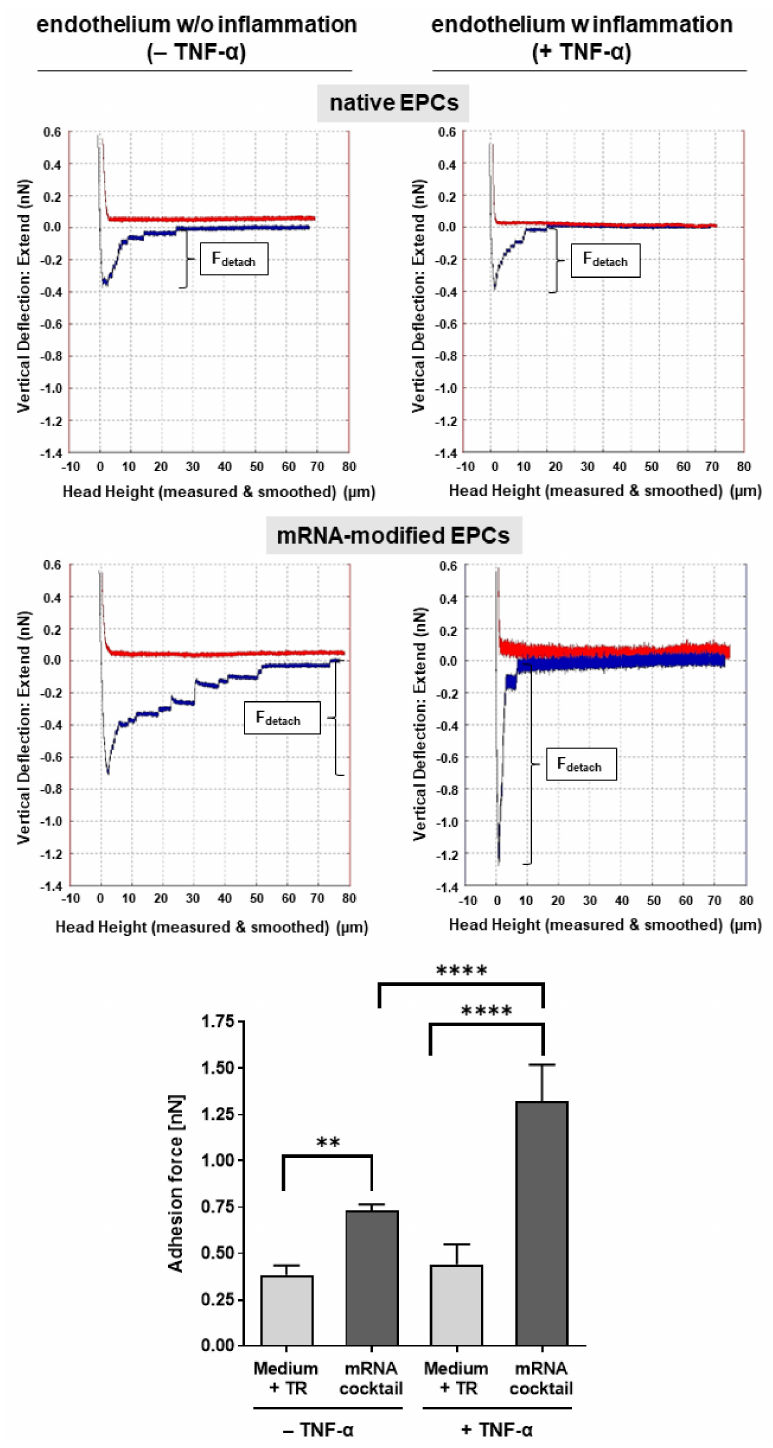
Figure 4. Analysis of the adhesion strength of EPCs to activated endothelium using single-cell atomic force microscopy (AFM). Representative histograms of the adhesion signature of CXCR4 and PSGL-1 mRNA (mRNA cocktail) modified and native EPCs to TNF- α -activated and nonactivated endothelium and the quantification of adhesion forces are shown. Bonds formed between the cell surface ligands (PSGL-1) and molecules on HUVECs (E-selectin) broke slightly with increasing force until the cell completely detached from the HUVEC. The maximum downward force of the cantilever’s tip is referred to as detachment force (F detach ). ( n = 4). Statistical analysis was performed using two-way ANOVA, followed by Bonferroni ´ s multiple comparisons test (** p < 0.01 and **** p <